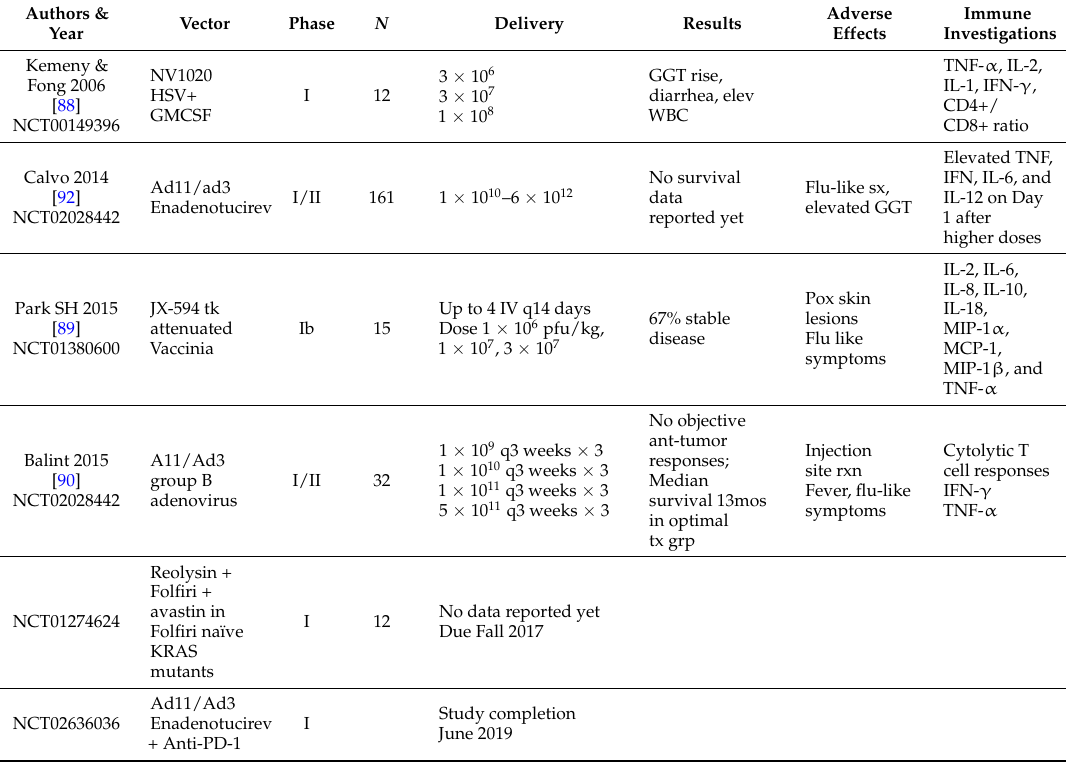
Table 2. Oncolytic viroimmunotherapy for colon cancer in clinical